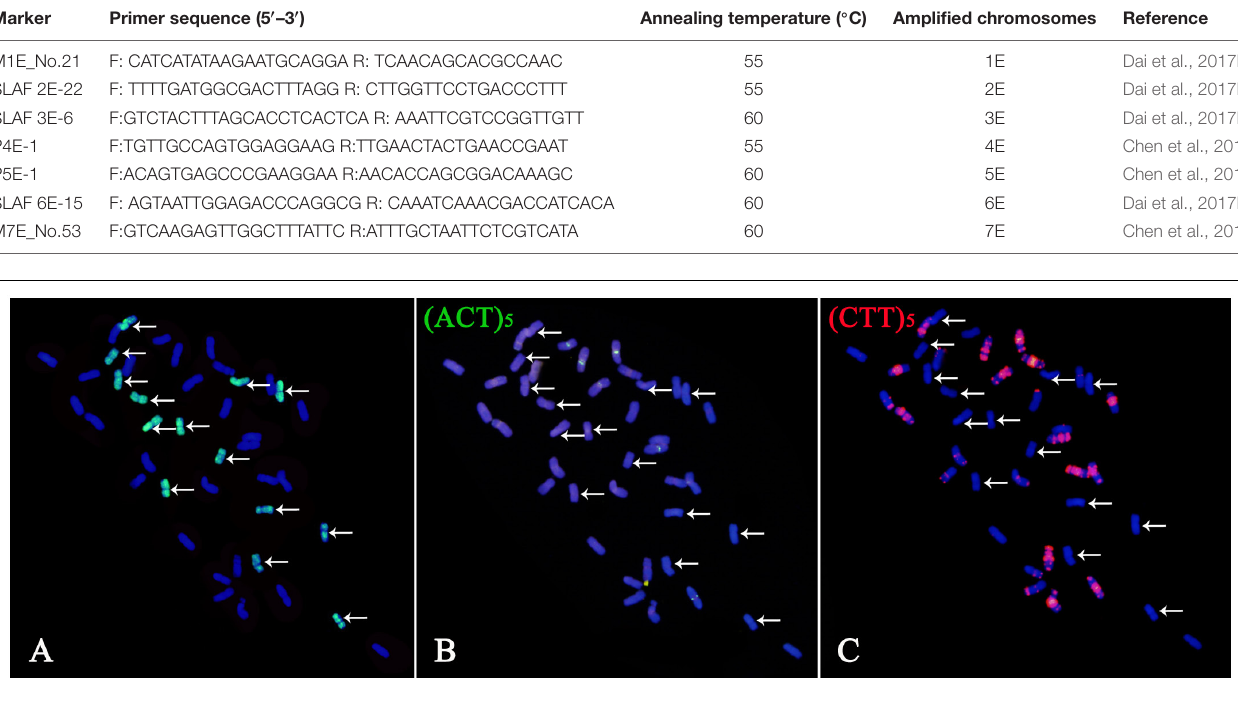
FIGURE 1 | Karyotyping of mitotic metaphase chromosomes of Trititrigia 8801 by sequential GISH-FISH. Arrows indicate E-genome chromosomes. (A) Tetraploid Thinopyrum elongatum genomic DNA was used as a probe for GISH (green). (B,C) (ACT) 5 and (CTT) 5 probe signals were pseudo-colored as green and red in the FISH patterns, respectively. The probes (ACT) 5 and (CTT) 5 failed to show any signals on the E-genome chromosomes.